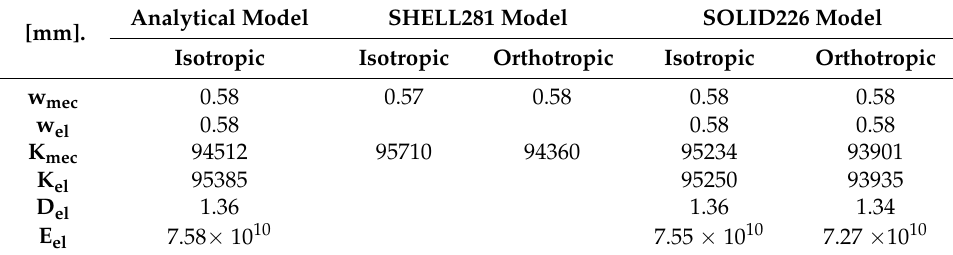
Table 6. Static analysis